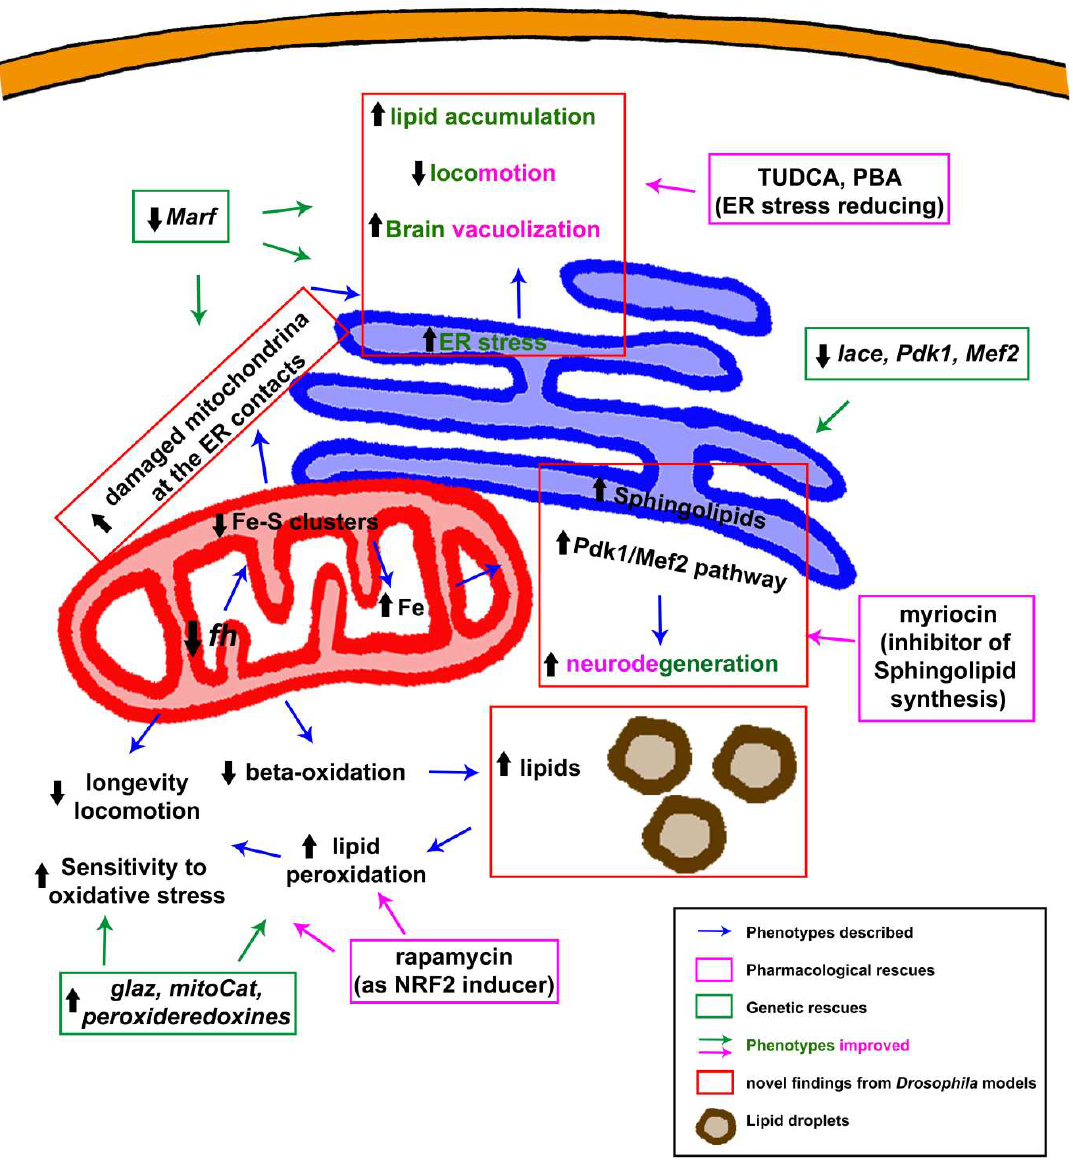
Figure 3. Graphic summary of molecular defects and rescues described in Drosophila melanogaster models of frataxin-deficiency in relation to oxidative stress and lipid metabolism.